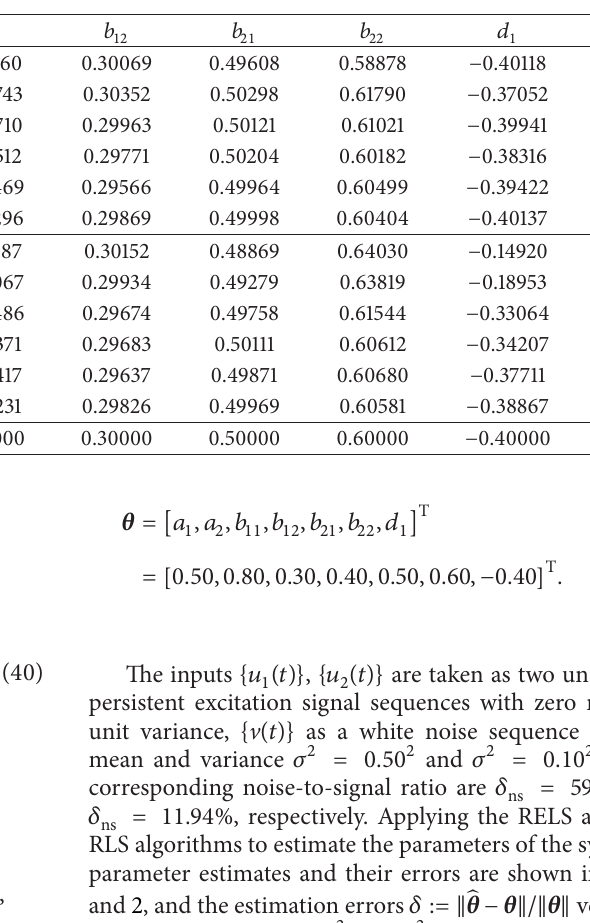
Table 2: The parameter estimates and their errors ( 𝜎 2 = 0.10 2 , 𝛿